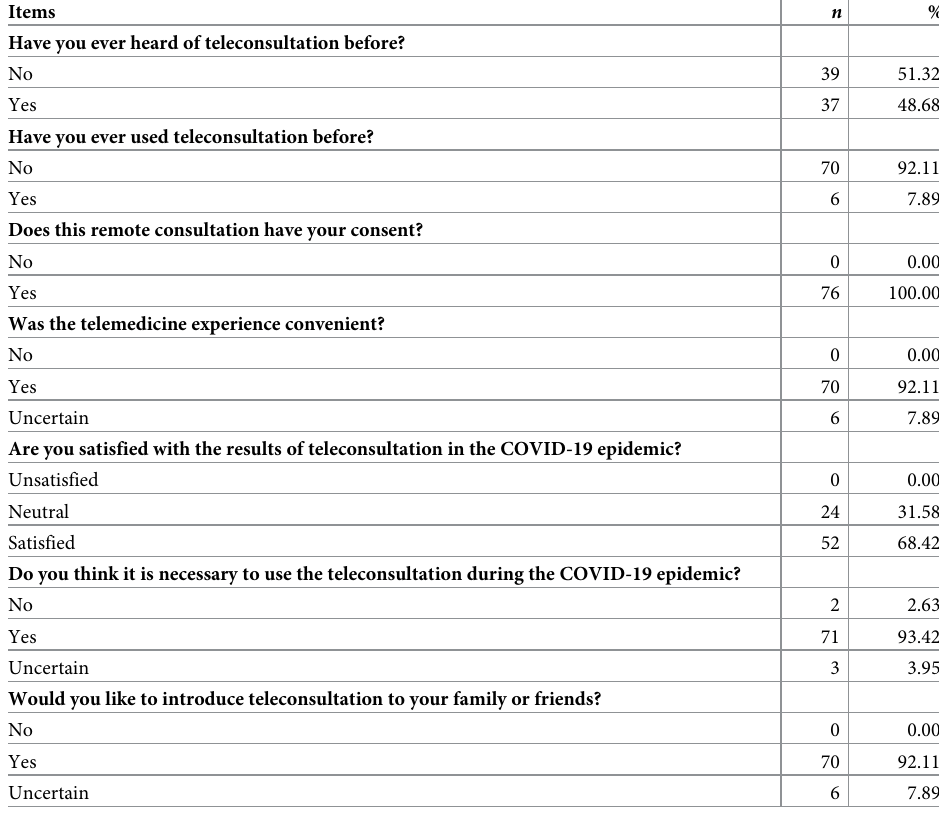
Table 8. The survey of satisfaction of patients who had experienced teleconsultation in the COVID-19 epidemic ( n = 76). Items n % Have you ever heard of teleconsultation before?